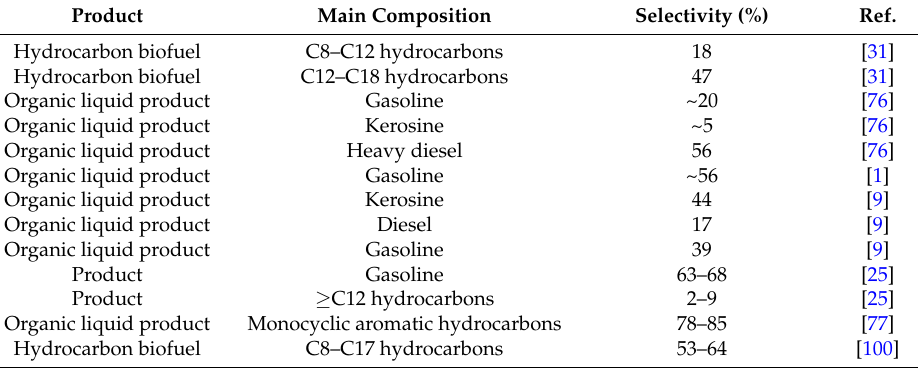
Table 8. The main composition of biofuel produced from vegetable oil